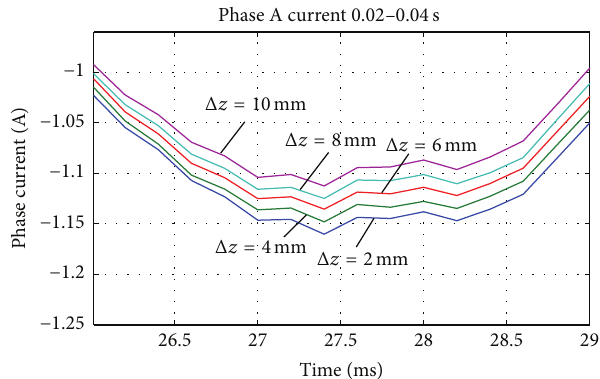
Figure 16: Enlarged view of the stator phase current (valleys).